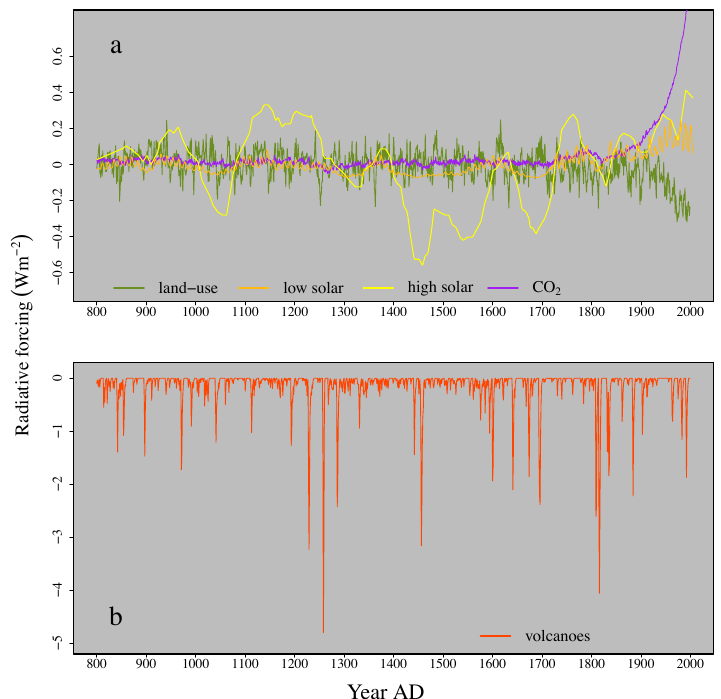
Fig. 2. Annual mean radiative forcing at the top of the atmosphere (Wm − 2 ) for (a) low solar (light orange), high solar (yellow), CO 2 (purple) and land-cover change (green); and for (b) volcanoes